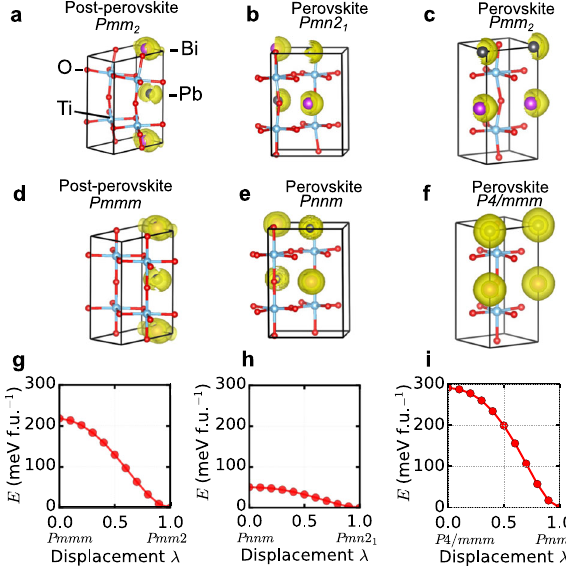
Fig. 4 Electron localization function (ELF) and the energy curve from the centrosymmetric structure to the corresponding polar structure. a The polar structure: post-perovskite Pmm 2 and d the centrosymmetric structure: post-perovskite Pmmm ; b The polar structure: perovskite Pmn 2 1 and e the centrosymmetric structure: perovskite Pnnm ; c The polar structure: perovskite Pmm 2 and f the centrosymmetric structure: perovskite P 4 = mmm . The isosurface of ELF is set at a value of ~0.5. g Transition from the post-perovskite Pmmm structure to the post-perovskite Pmm 2 structure. h Transition from the perovskite Pnnm structure to the perovskite Pmn 2 P 4 = mmm structure to the 1 structure. i Transition from the perovskite perovskite Pmm 2